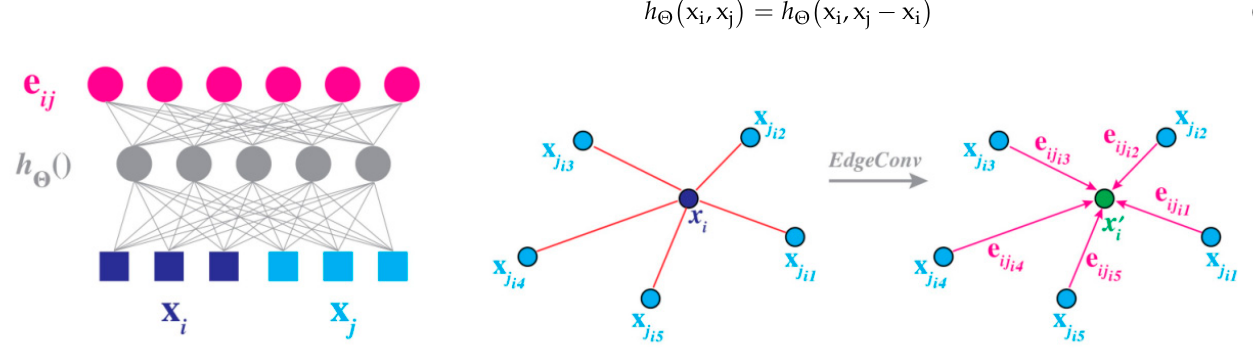
Figure 3. In order to better capture neighborhood information, this study set the h function, as shown in Formula (3).